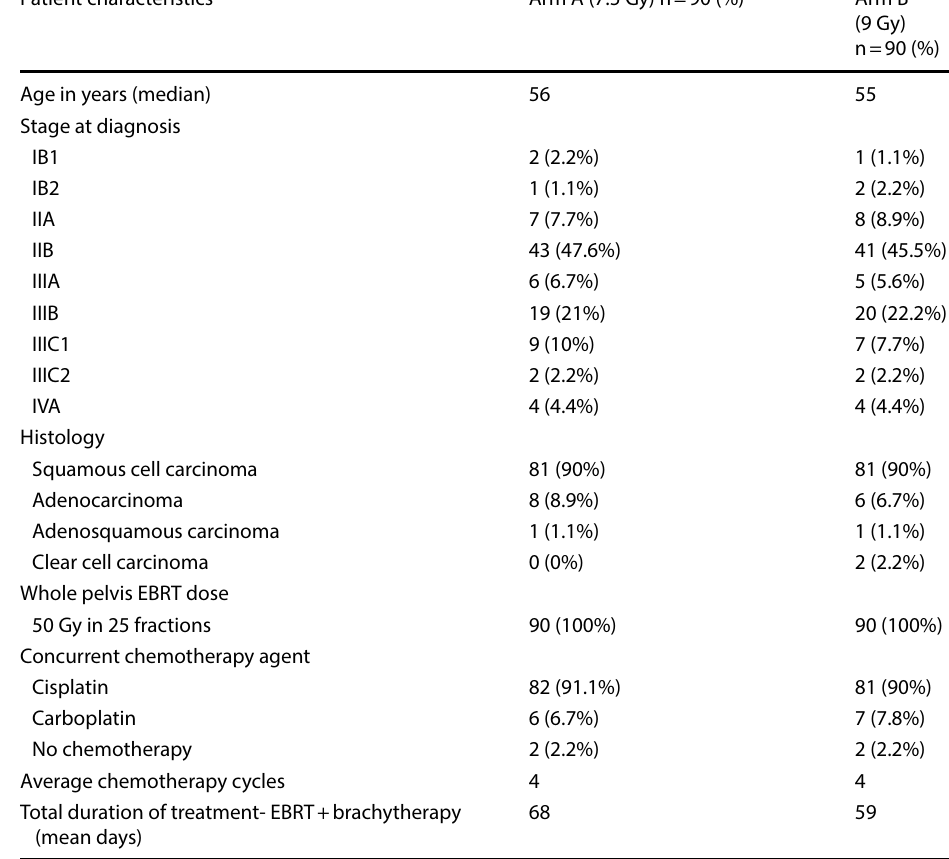
Patient characteristics